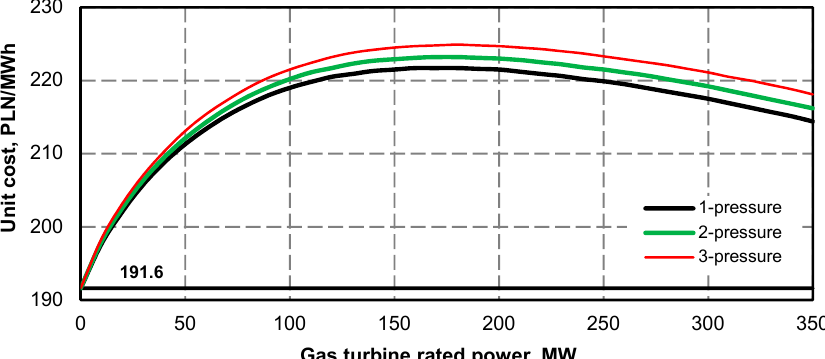
Figure 42. Unit generation cost for electric power as a function of gas turbine rated power for various structures of recovery boiler ( e c = 12 PLN/GJ, e g = 27.7 PLN/MWh, (k el ) ex = 191.6 PLN/MWh).